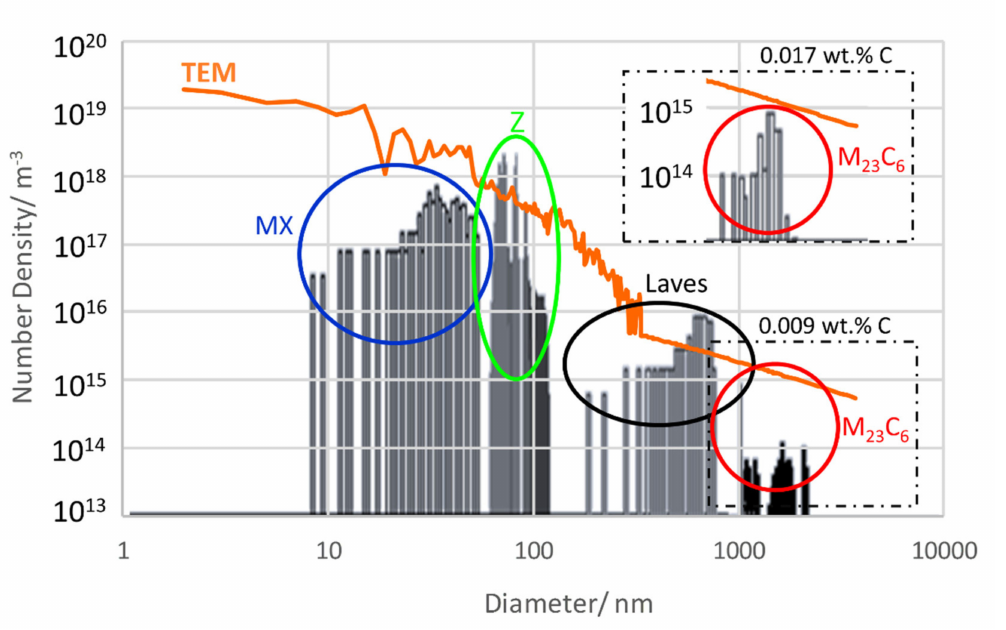
Figure 14. Size distributions of Z6 in aged condition 2 (700 ◦ C/1000 h); simulated vs. measured.